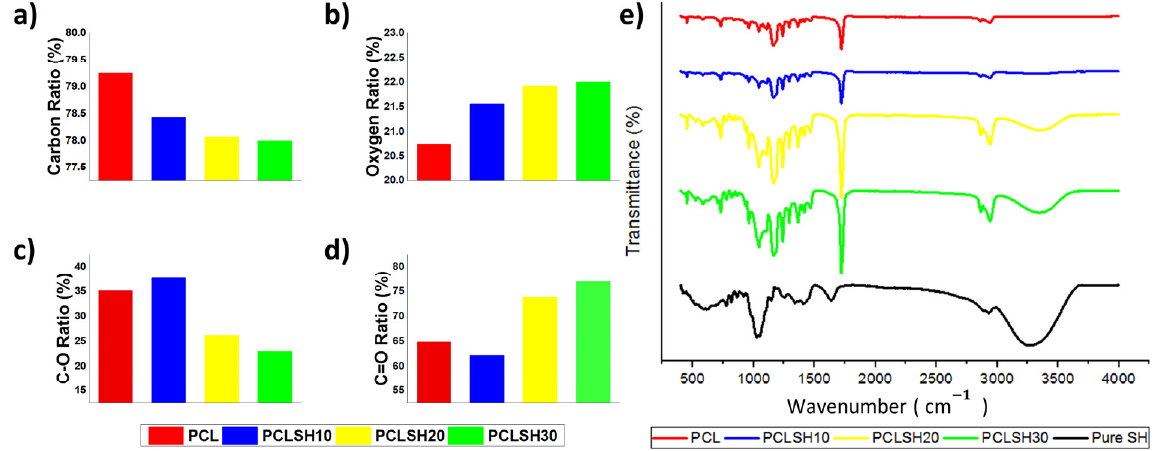
Figure 4. Electrospun mesh ( a ) carbon, ( b ) oxygen, ( c ) C-O, ( d ) C=O percentage ratios, and ( e ) FTIR spectrum.